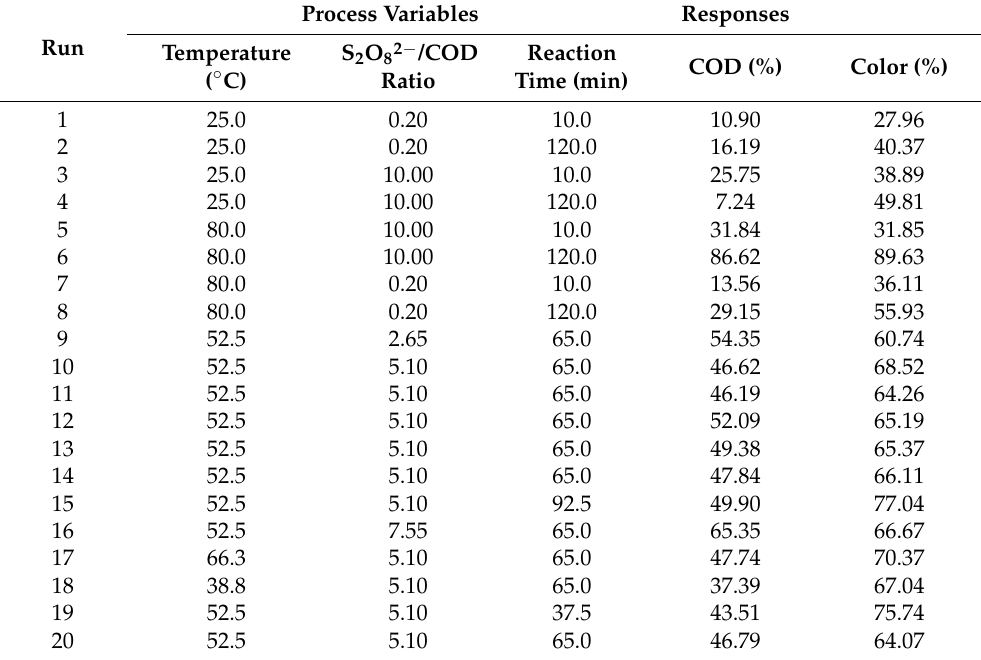
Table 2. Summary of CCD batch experiments and their response